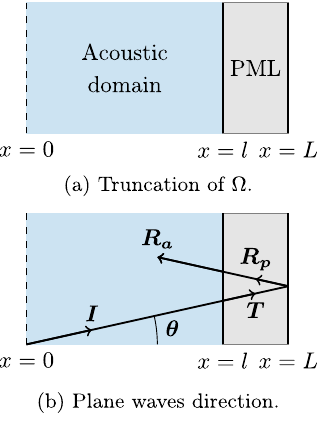
Figure 1. Model bounded with an absorbing